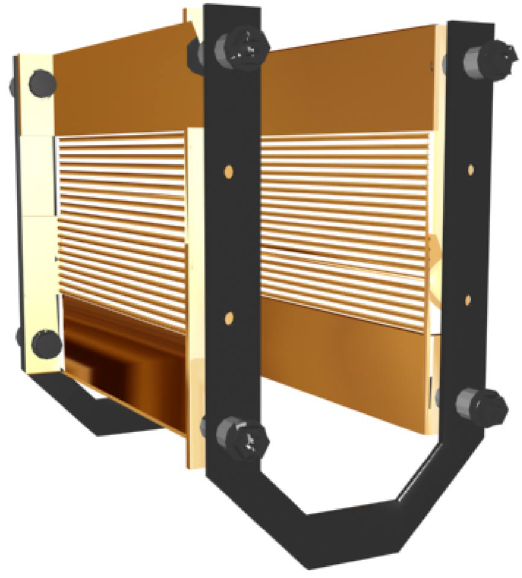
FIG. 6. (Color) Calculated potential distribution within the electrostatic 15 (cid:3) deflector.